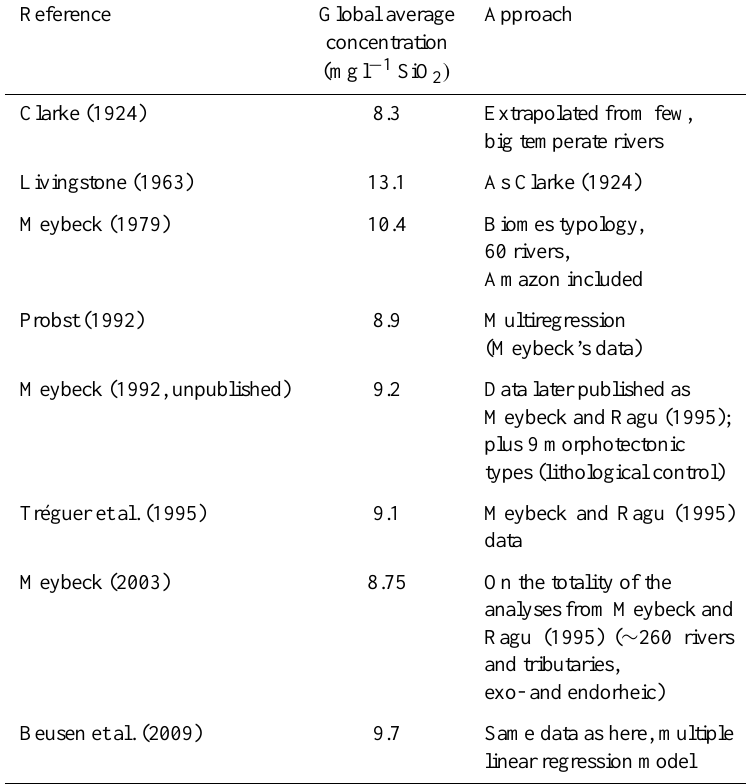
Table 5. Existing global budgets and values of ranges for dissolved silica